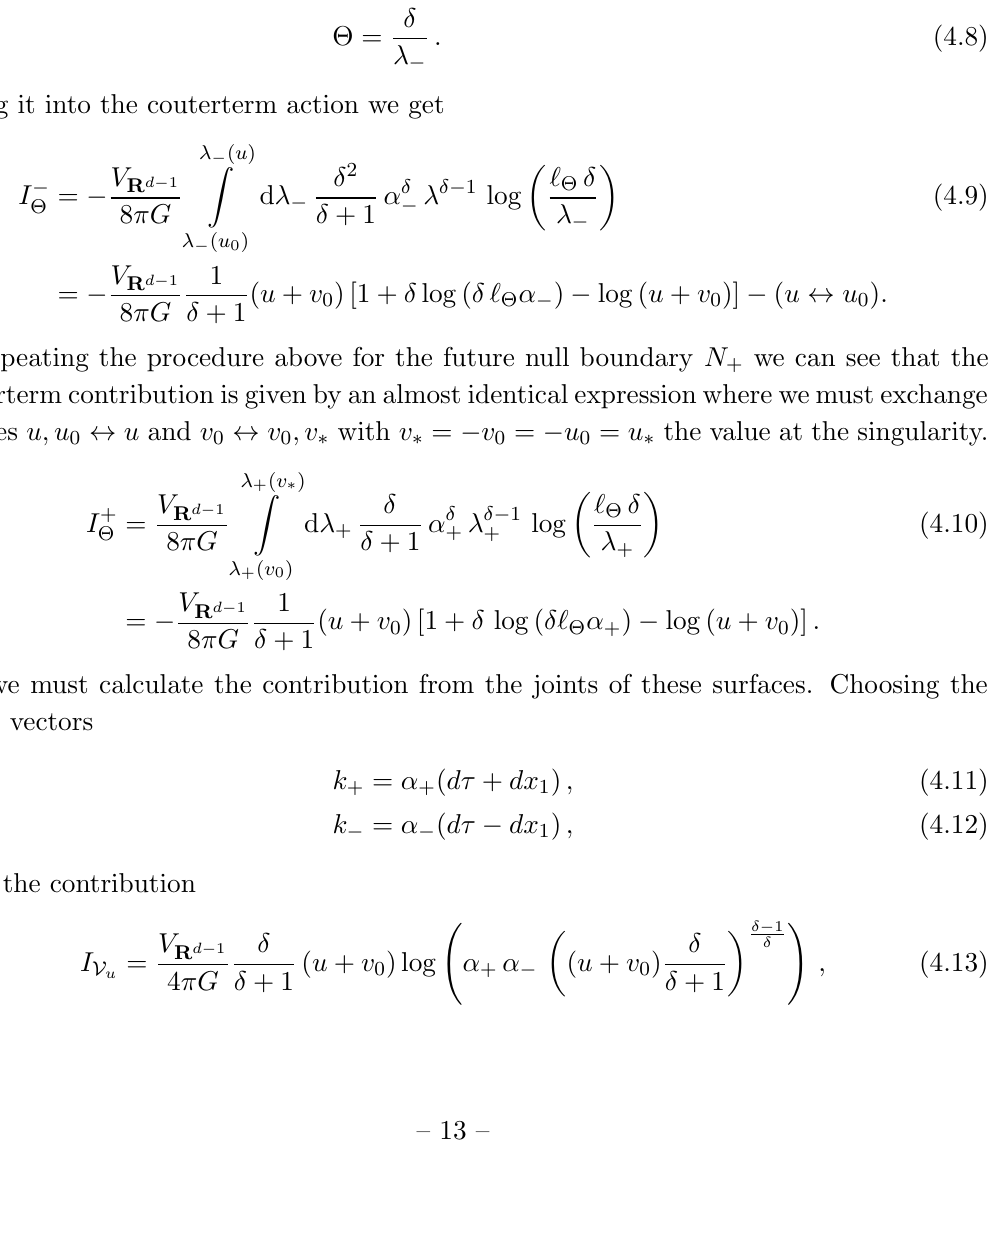
(cid:2) (cid:3) = (cid:0) u ; u (cid:2) R d (cid:0) 1 u 2 2